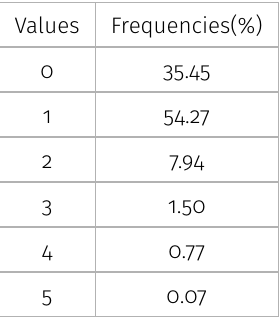
Table III. NOC in system category.